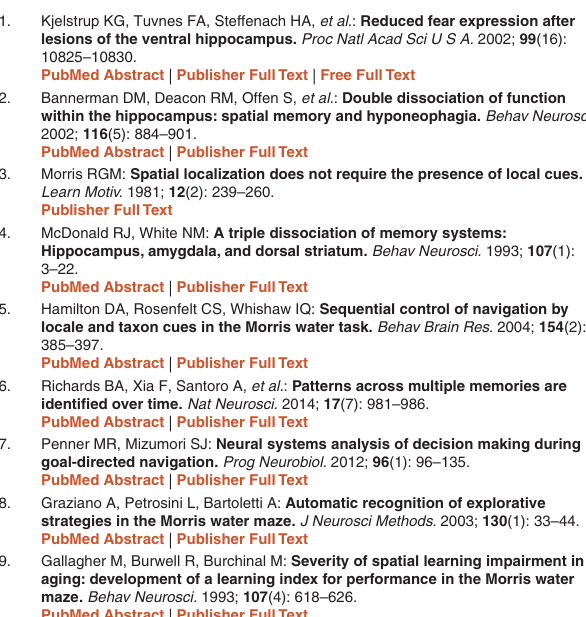
Figshare: Raw data for “Pathfinder: open source software for analyzing spatial navigation search strategies”,